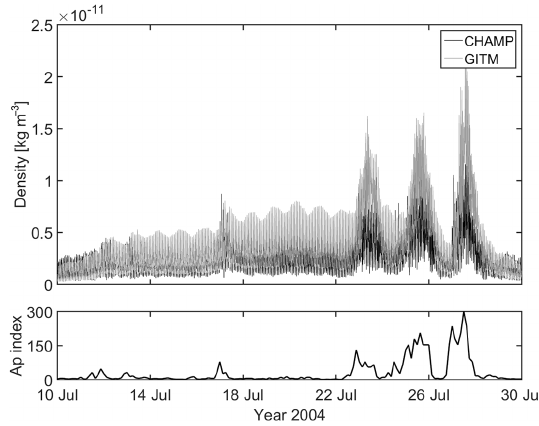
Figure 4. Daily (grey line) and 81-day-averaged (black line) solar flux received on Earth at 10.7cm wavelength between 1980 and 2015. The grey region represents the selected investigation period.